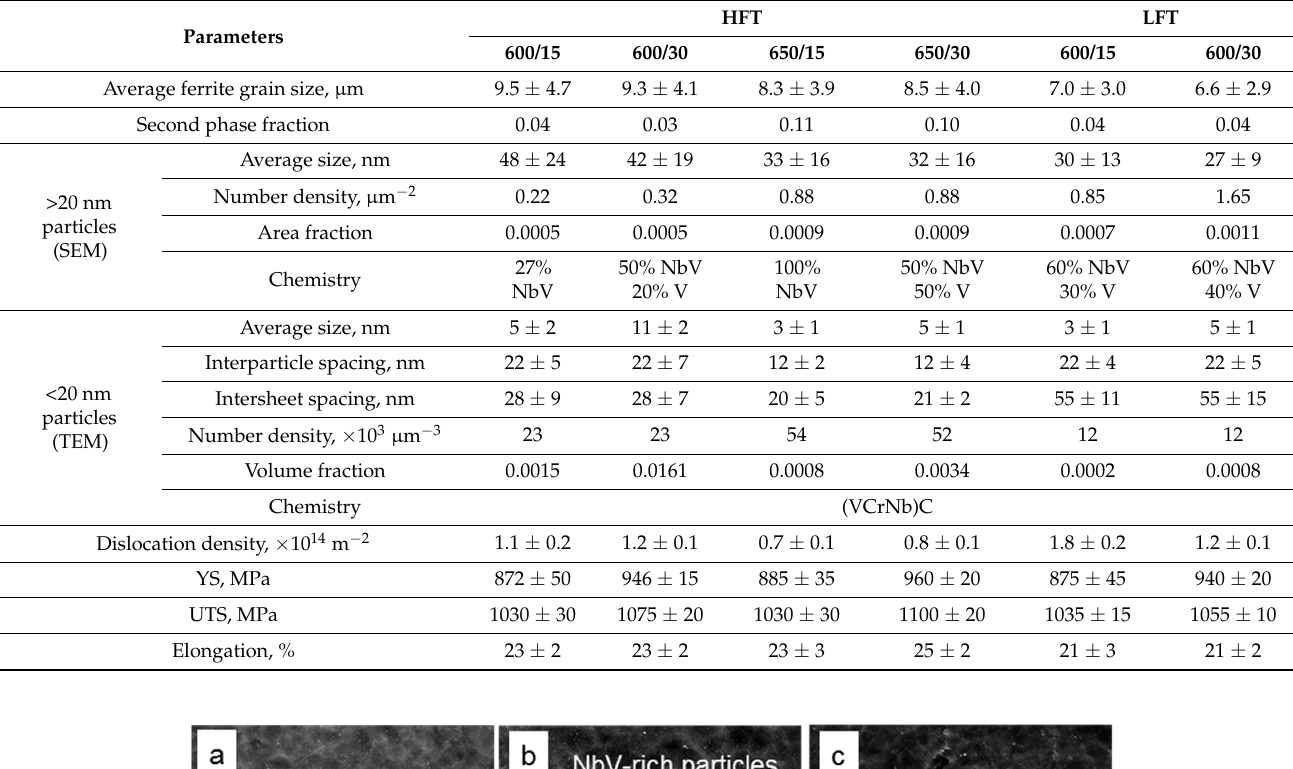
Table 2. Microstructural parameters and mechanical properties in the studied steel.